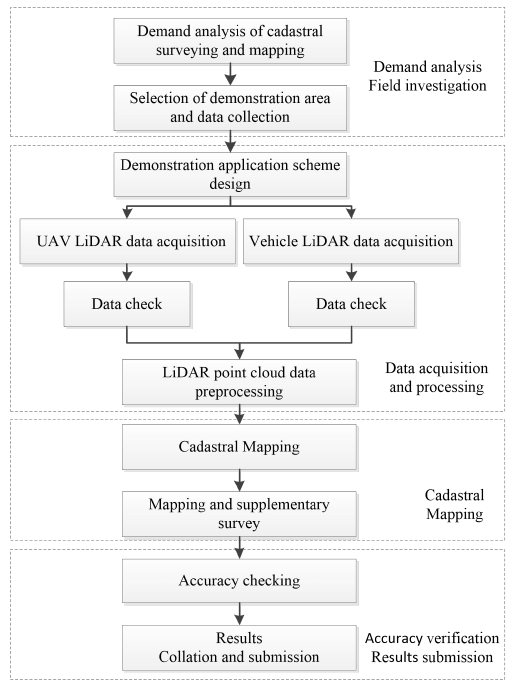
Figure 1 The workflow of this paper.